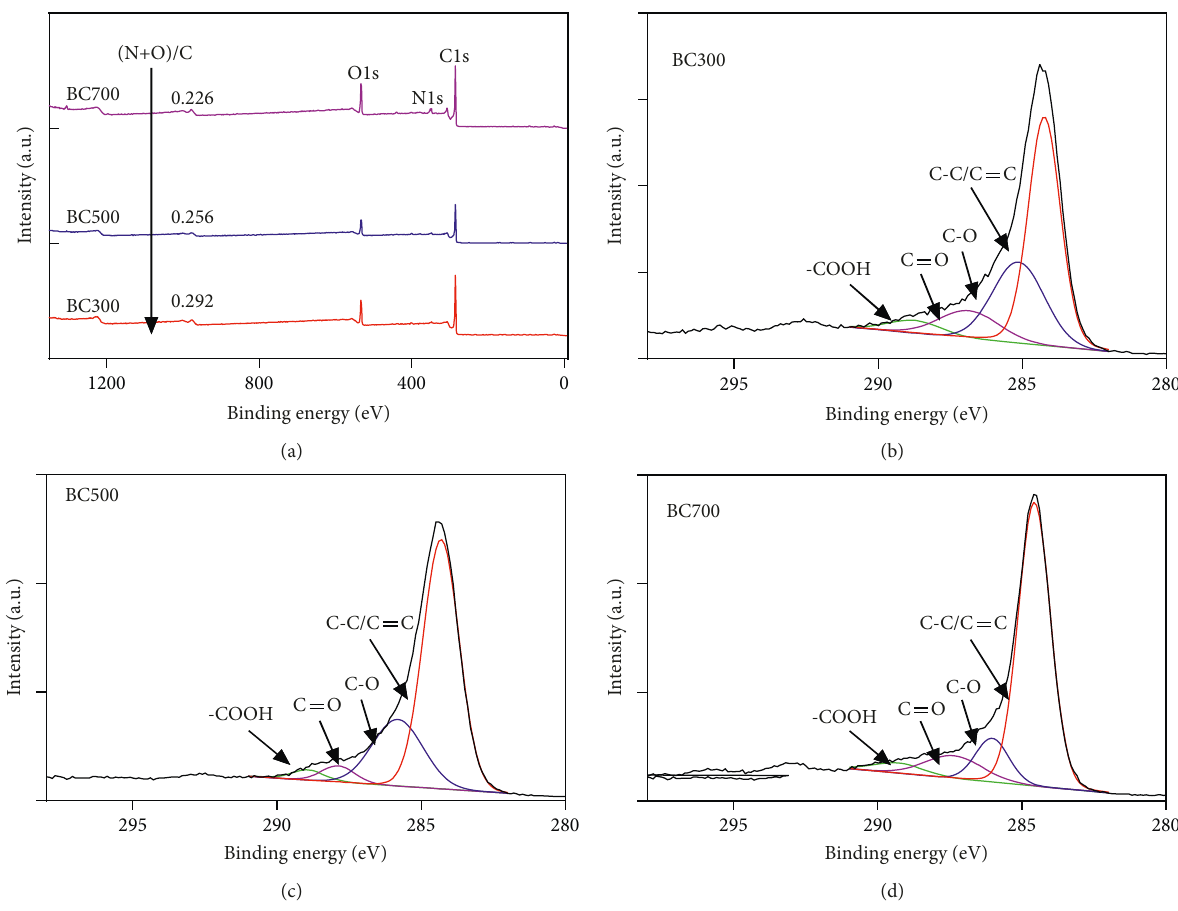
Figure 4: X-ray photoelectron spectroscopy (XPS) spectra and the C1s spectra of BC300, BC500, and BC700.